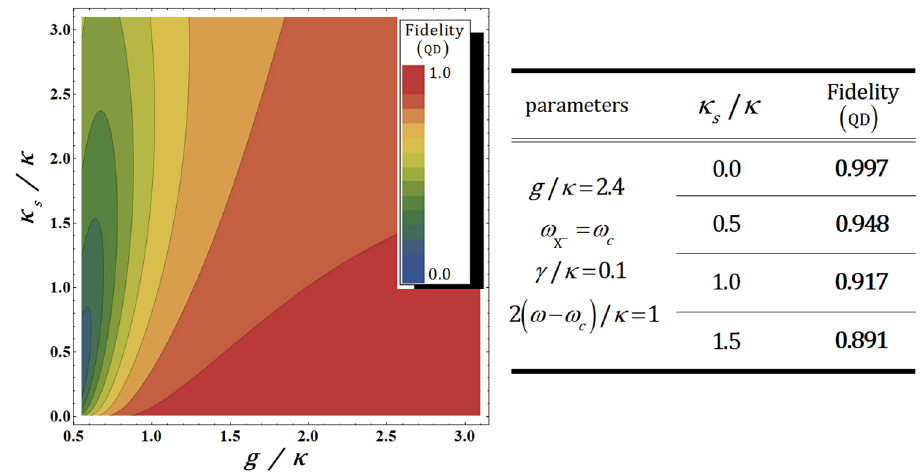
Figure 5. The left plot represents the fidelities F QD (QD inside a single-sided cavity) of the output state with respect to the differences in side leakage rate κ s / κ and the coupling strength g / κ between the QD and the cavity with fixed γ / κ = 0.1 and ω ω = − . The right table is a list of the values of F QD for κ s / κ = 0.1, 0.5, 1.0, and 1.5 c X with fixed parameters g / κ = 2.4 and 2( ω − ω c )/ κ =